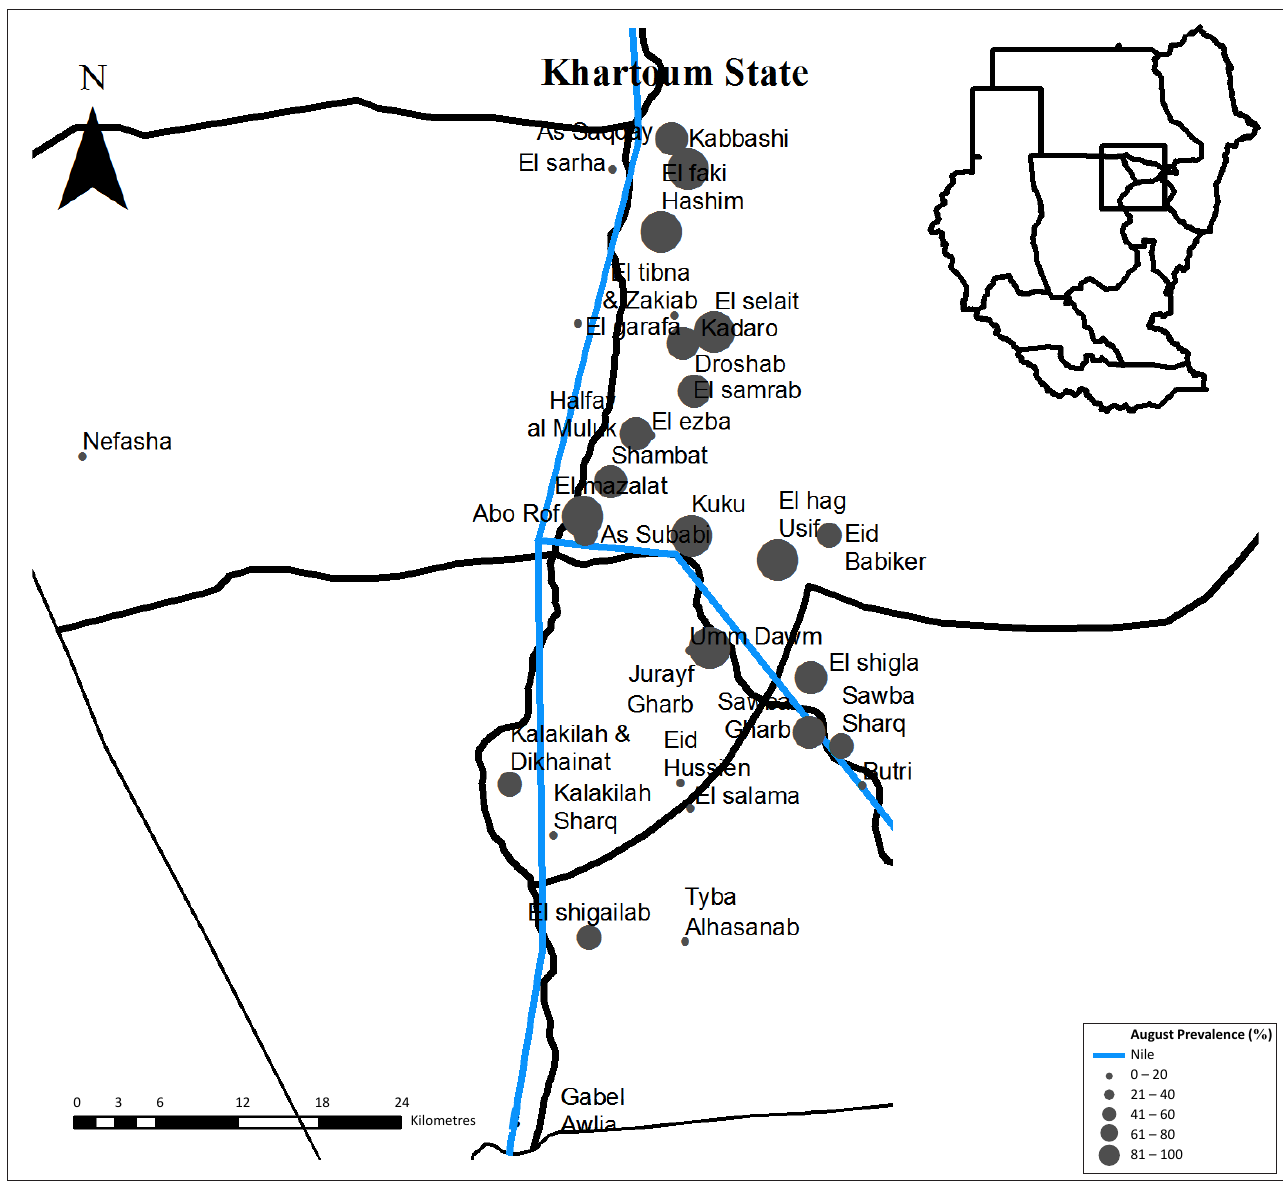
Source : Figure created from census data by using ArcGIS FIGURE 4: Spatial distribution of antimicrobial residues in Khartoum State farms surveyed in August 2008.